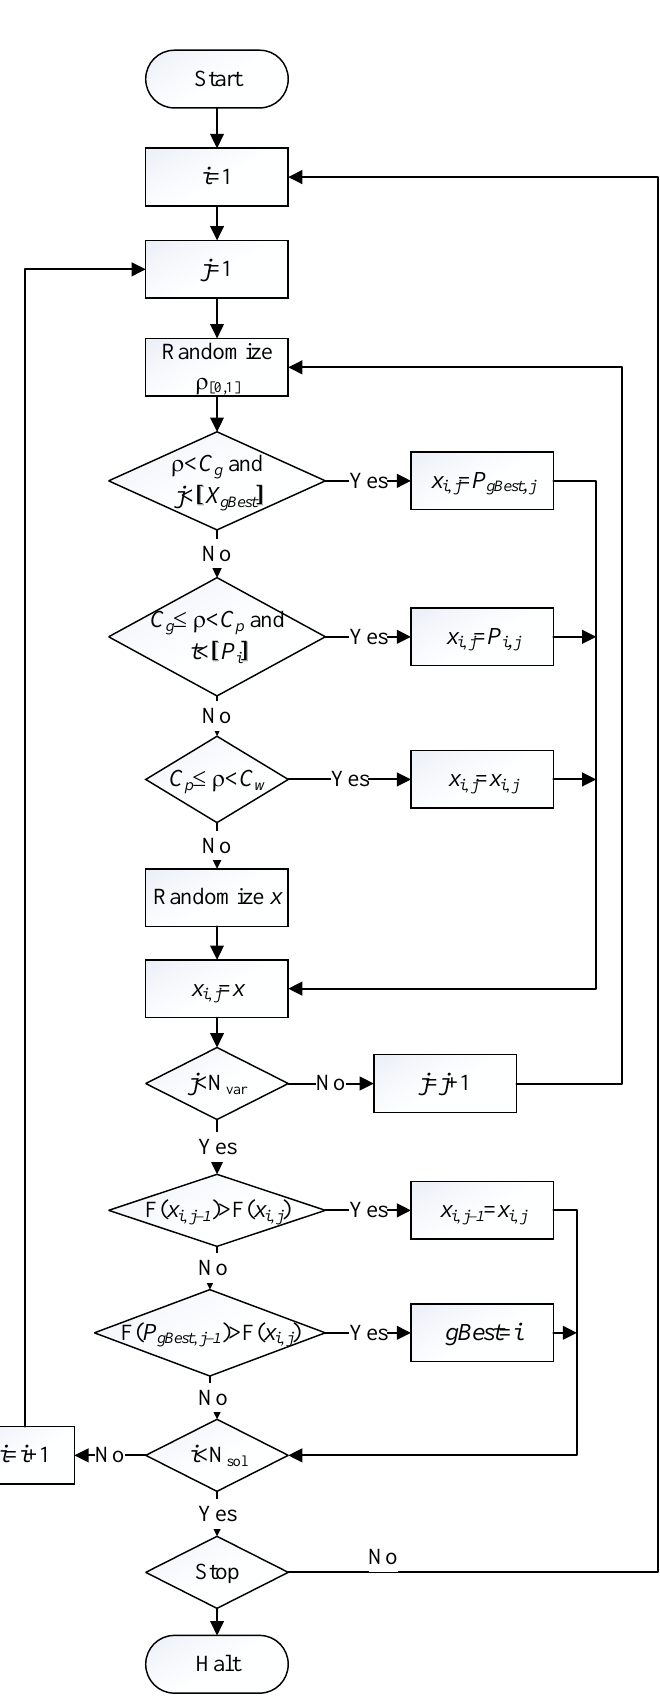
Figure 6. Flowchart of the proposed fSSO.